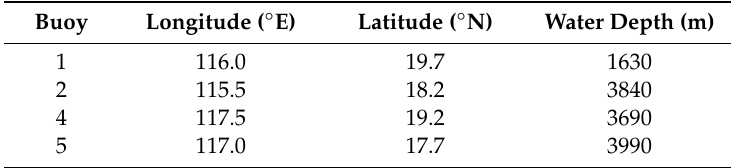
Table 1. Coordinates and ocean depth at observation points (Buoys 1, 2, 4 and 5) shown as yellow triangles in Figure